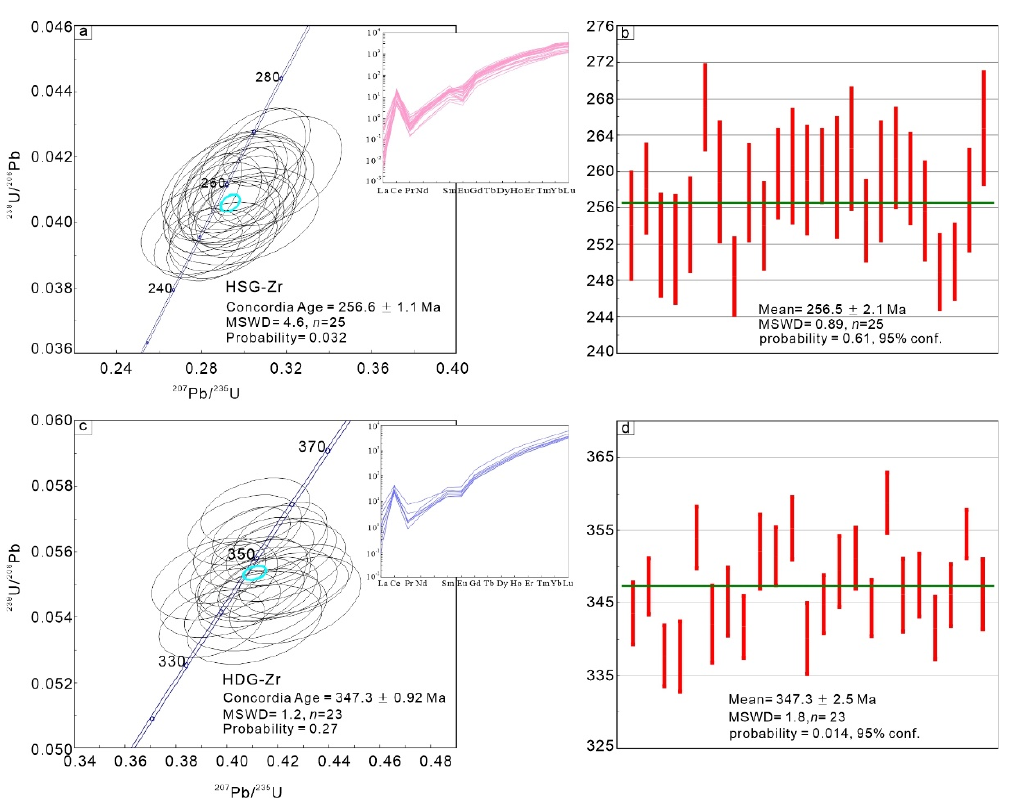
Figure 4. ( a ) U ‐ Pb concordia diagram of the zircons from the HSG. ( b ) Weighted mean 206 Pb/ 238 U age of the zircons from the HSG. ( c ) U ‐ Pb concordia diagram of the zircons from the HDG. ( d ) Weighted mean 206 Pb/ 238 U age of the zircons from the HDG.5.2. Apatite U ‐ Pb Ages.